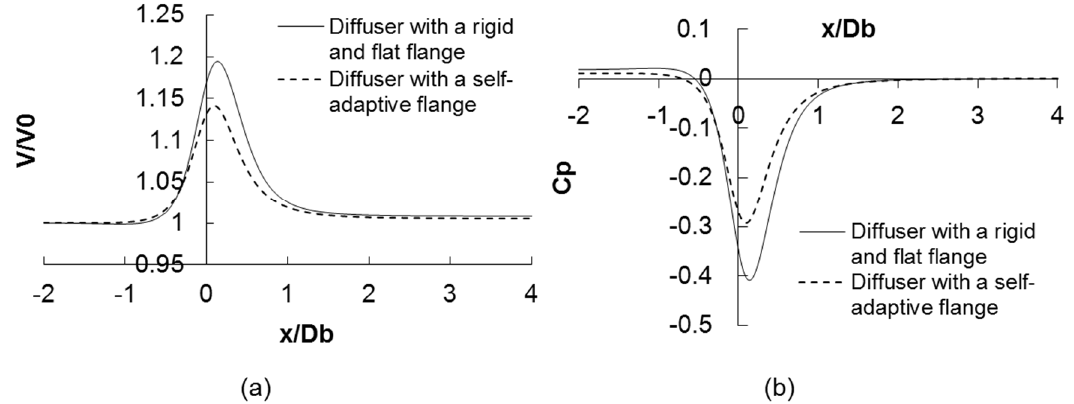
Figure 15. Distributions of streamwise velocity and pressure coefficient along the axisymmetric axis in the flanged diffusers with a rigid and flat and with a bended self-adaptive flange: ( a ) streamwise velocity and ( b ) pressure